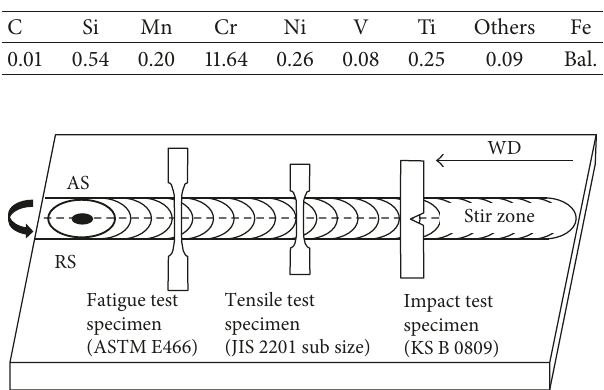
Figure 1: Schematic illustration of the friction stir welding process and test